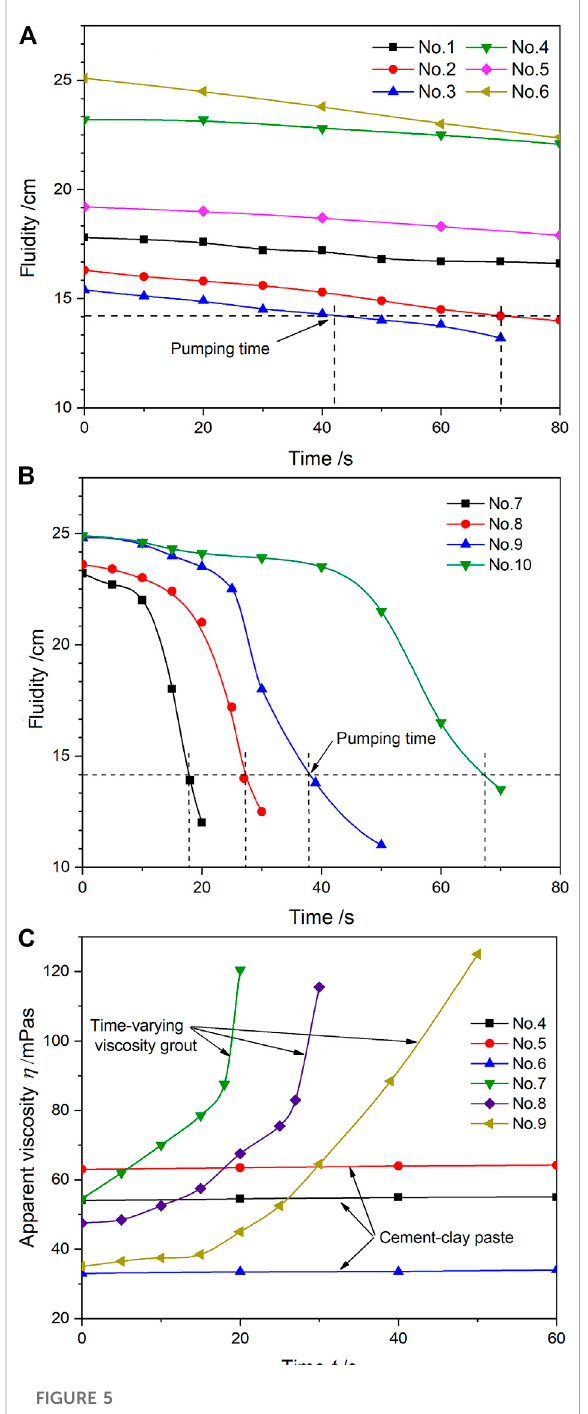
FIGURE 5 The variation of fl uidity and viscosity with time for the cement-clay slurry and the time-dependent viscosity